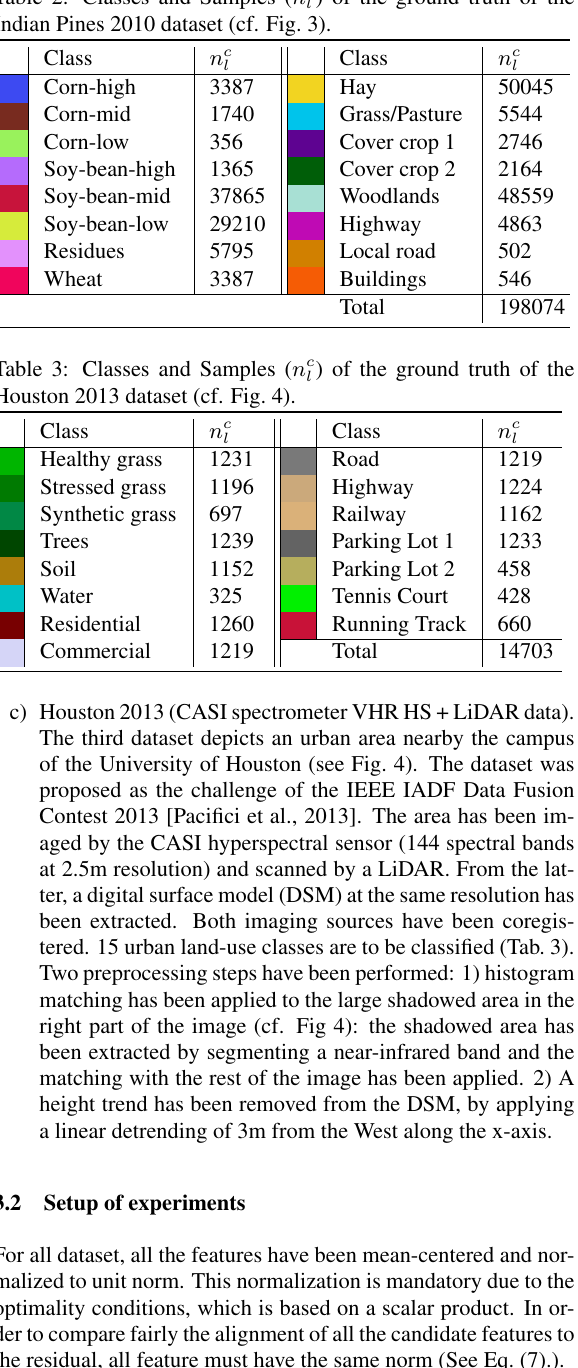
) of the ground truth of the l